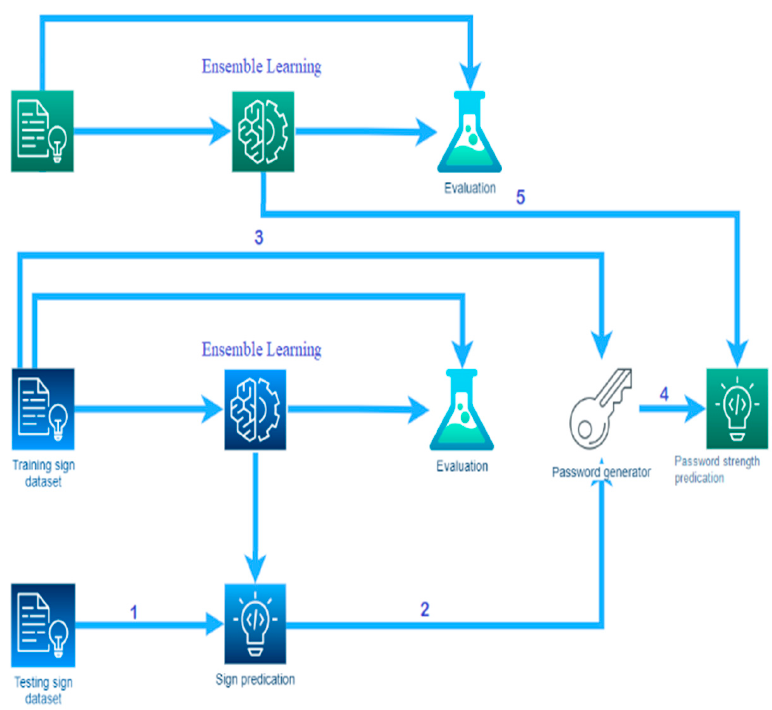
Figure 3. The block diagram of the password generation and estimation.